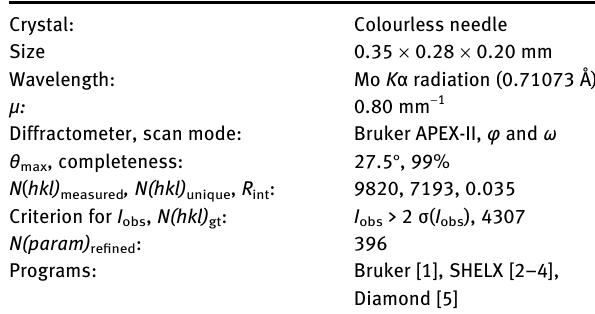
Table  : Data collection and